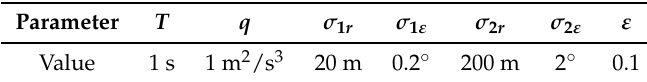
Table 2. The Simulation